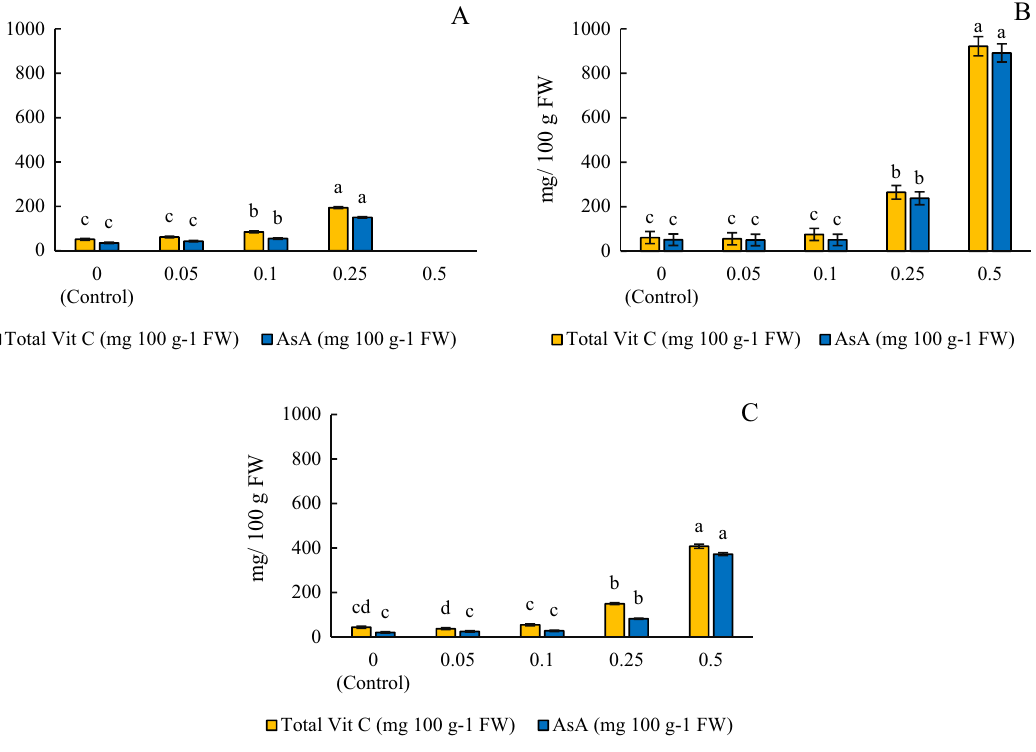
Figure 1. Average of concentrations of total Vit C and ascorbic acid (AsA) in fresh weight (FW) of each treatment treated with different concentrations of ascorbic acid in ( A ) Experiment 1—greenhouse conditions, ( B ) Experiment 2—greenhouse conditions, and ( C ) Experiment 3—laboratory conditions. Significant differences ( p ≤ 0.05) among treatments are indicated by different lowercase letters within the experiment. (n = 5). Bars represent ± 1 standard error of the mean. FW fresh weight. Experiment-1 (greenhouse) Treatment (% ascorbic acid)